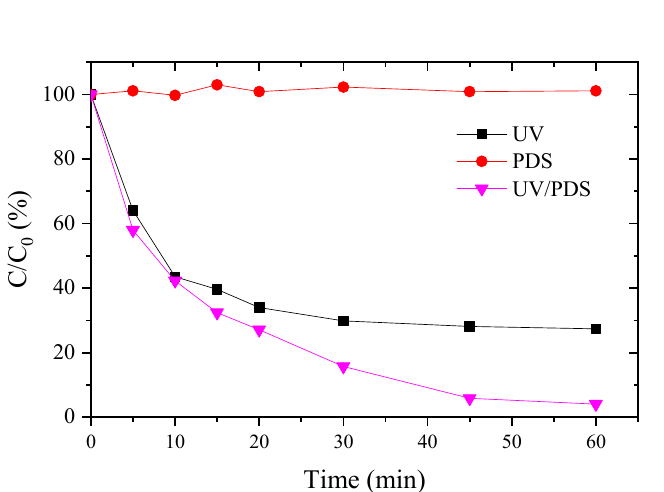
Figure 1. The effects of different oxidation processes on sulfathiazole (STZ) removal. Conditions: [STZ] = 10 mg/L, [peroxodisulfates (PDS)] = 300 mg/L and UV (ultraviolet) irradiation: 2 mW/cm 2 .